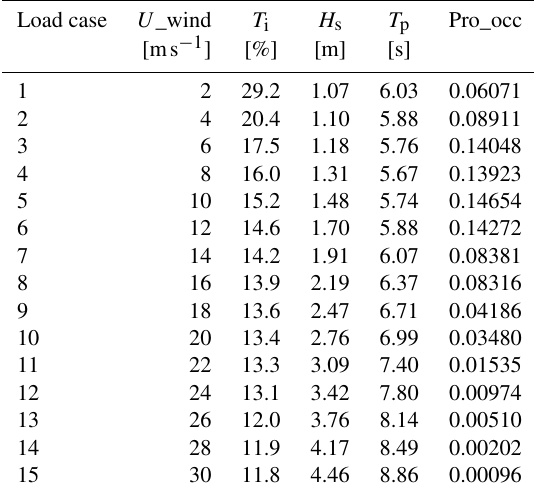
Table 1. Environmental